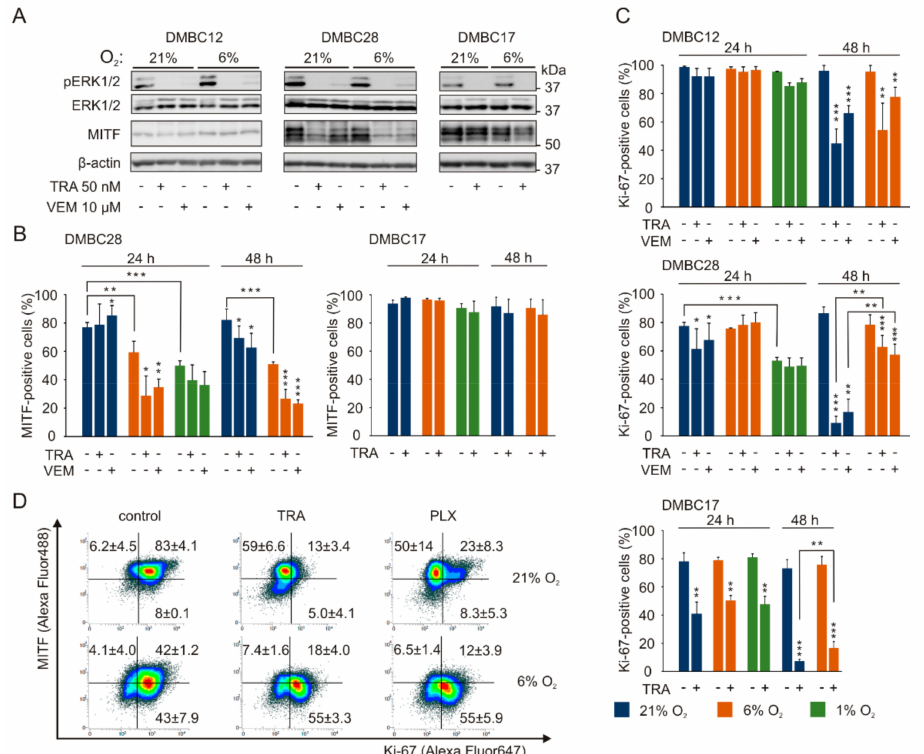
Figure 5. Vemurafenib and trametinib while targeting the MAPK / ERK pathway irrespective of oxygen concentration, affect MITF-positive and Ki-67-positive melanoma cells in oxygen- and cell line-dependent manner. ( A ) The effects of trametinib (TRA) and vemurafenib (VEM) on ERK1 / 2 activity and MITF level in 21% and 6% O 2 were determined by Western blotting with representative images shown ( n = 3). β -actin was used as a loading control. ( B ) The percentage of MITF-positive cells in control cultures and after treatment with either 50 nM trametinib (TRA) or 10 µ M vemurafenib (VEM) are shown as mean values ± SD ( n = 3). Results for DMBC12 were not quantified due to almost undetectable MITF level in control and lack of changes in drug-treated cells. Differences are considered significant at * p < 0.05 ** p < 0.01 *** p < 0.001. See Figure S1 for representative dot plots. ( C ) The percentage of Ki-67-positive cells in control cultures and after treatment with 50 nM trametinib or 10 µ M vemurafenib are shown as mean values of 3 biological replicates ± SD. Differences are considered significant at * p < 0.05 ** p < 0.01 *** p <